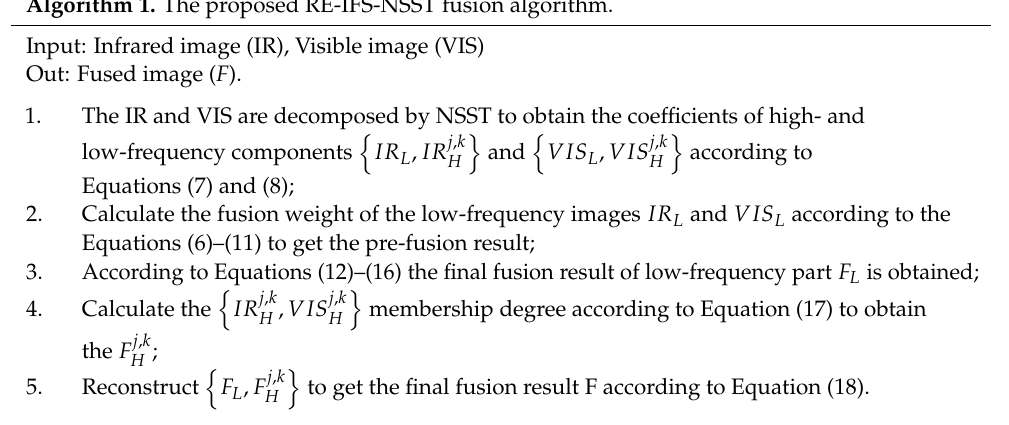
Algorithm 1. The proposed RE-IFS-NSST fusion